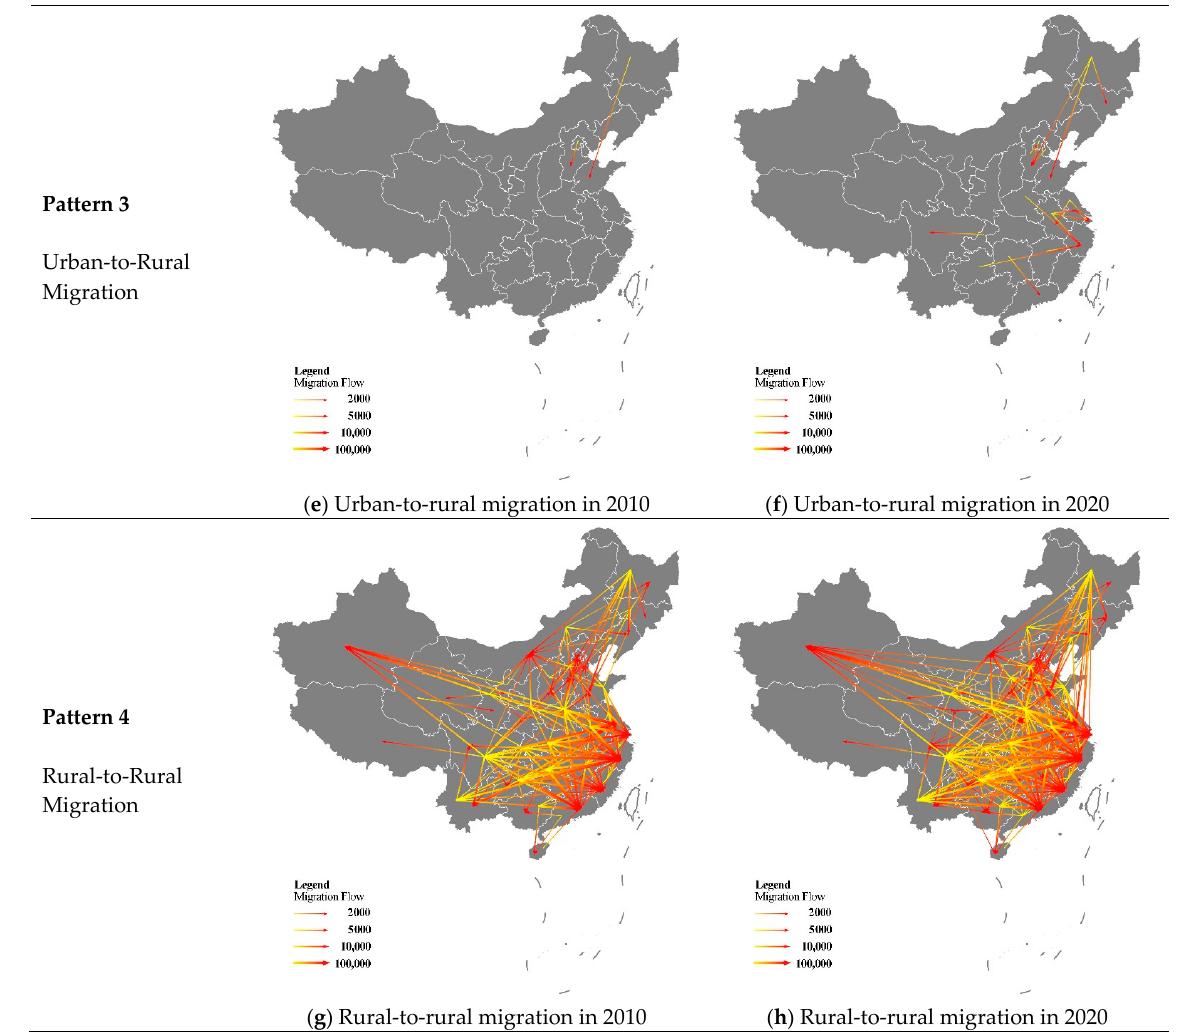
Figure 2. Four migration patterns in 2010 and 2020.